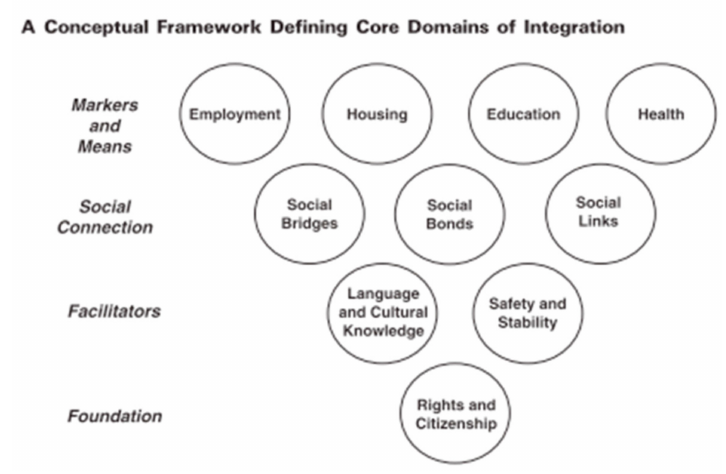
Figure 1. Ager and Strang (2008, p.